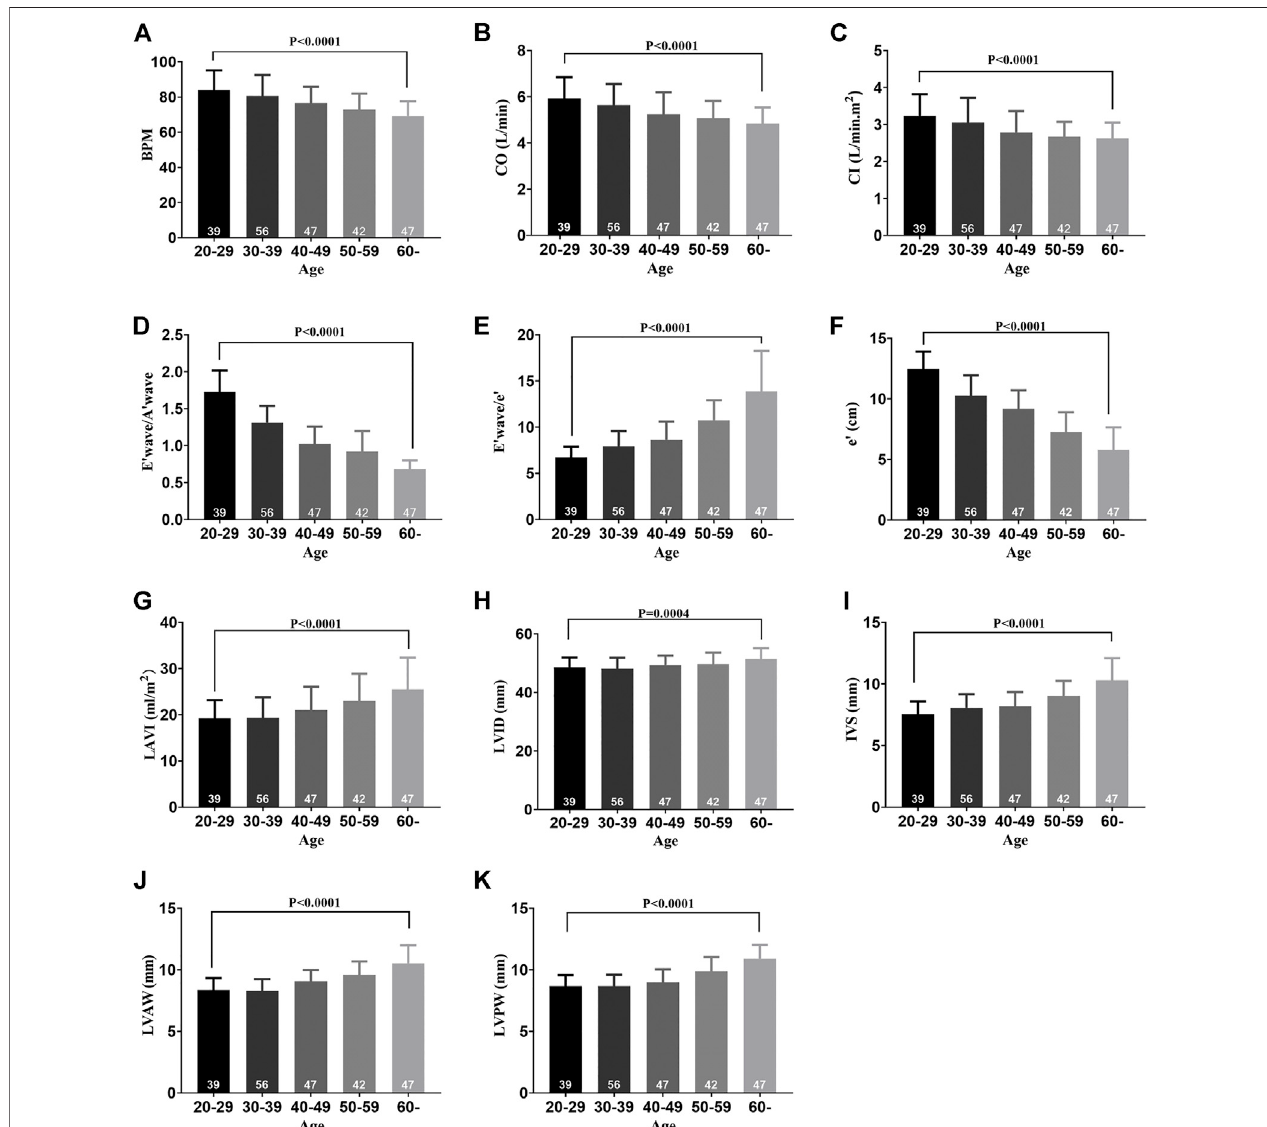
FIGURE 1 | Cardiac function decline and left ventricle remodeling with aging in healthy participants. (A) BPM of fi ve groups. (B) CO of fi ve groups. (C) CI of fi ve groups. (D) E ′ wave/A ′ wave ratios of fi ve groups. (E) E ′ wave/e ’ ratios of fi ve groups. (F) e ’ of fi ve groups. (G) LAVI of fi ve groups. (H) LVID of fi ve groups. (I) IVS of fi ve groups. (J) LVAW of fi vegroups. (K) LVPW of fi vegroups. Results aremeans ±SEM.A p -valueof < 0.05wasconsidered signi fi cant.BPM: beatper minute. CO: cardiac output. CI: cardiac index. E ’ wave: maximum fl ow velocity of mitral valve in early diastole. A ’ wave: maximum fl ow velocity of mitral valve in late diastole. e ’ : mean diastolic velocity of mitral annulus in diastole. LAVI: left atrial volume index. LVID: left ventricular internal dimension. IVS: interventricular septum. LVAW: left ventricular anterior wall. LVPW: left ventricular posterior